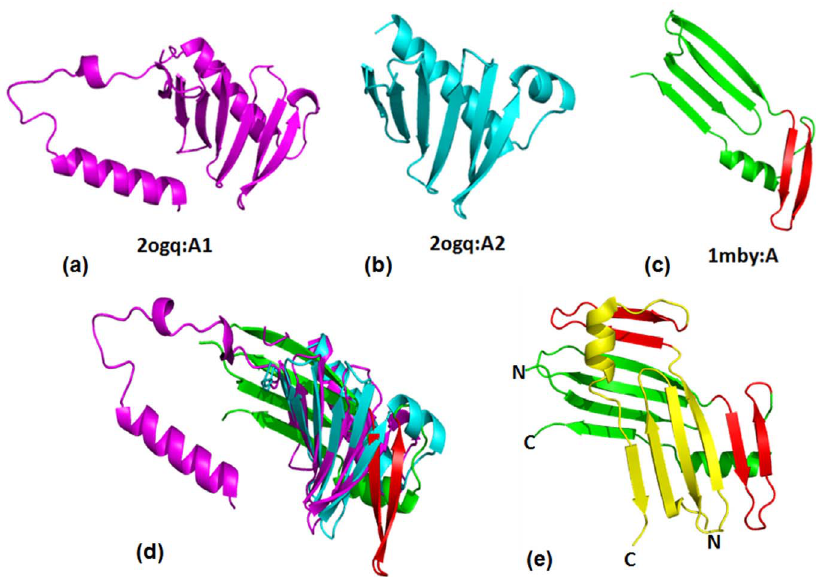
Figure 8. The structural view of members of the polo-box domain superfamily. (a) and (b) are polo-box domain from the family ‘‘polo-box duplicated region’’ (c) 1mby:A is a structurally deviant member of the superfamily which belongs to swapped polo-box domain family.(d) superimposed view of all the three domains shows the alignment is not good. (e) Dimeric form of Polo-box domain in swapped conformation (PDB ID: 1mby). The swapped part is highlighted in